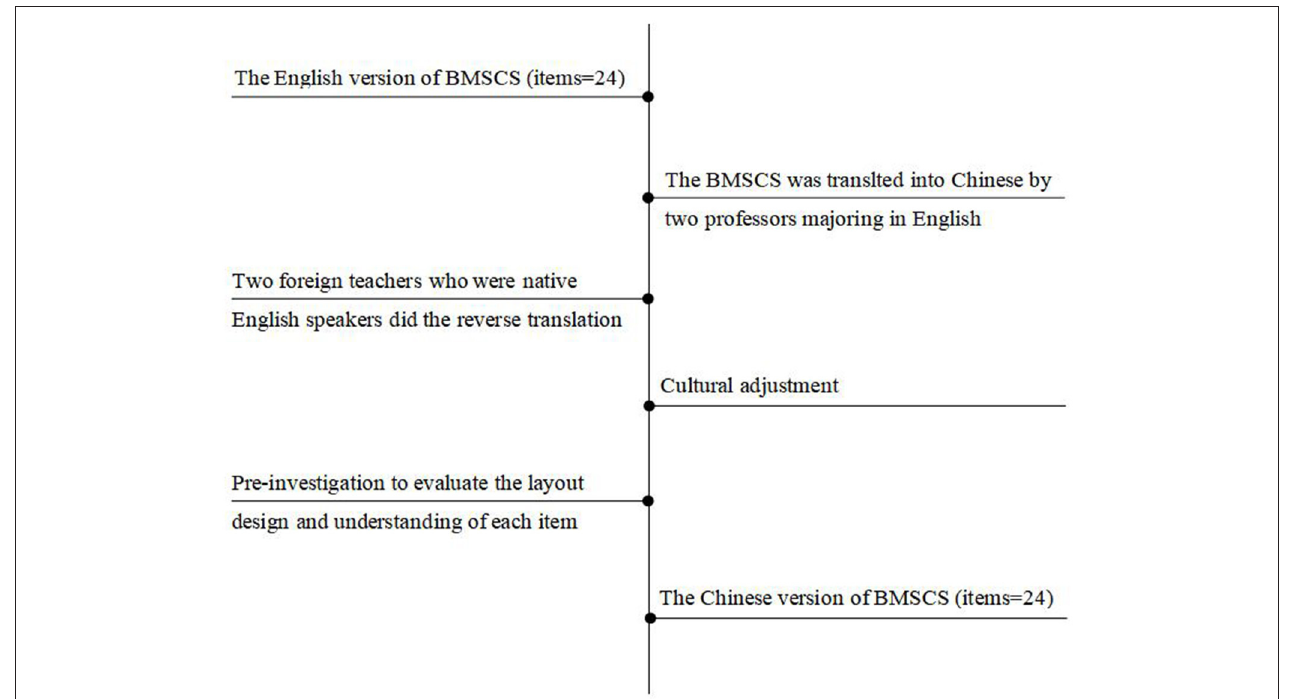
FIGURE 1 | The translation procedure for Chinese version of the B-MSCS.